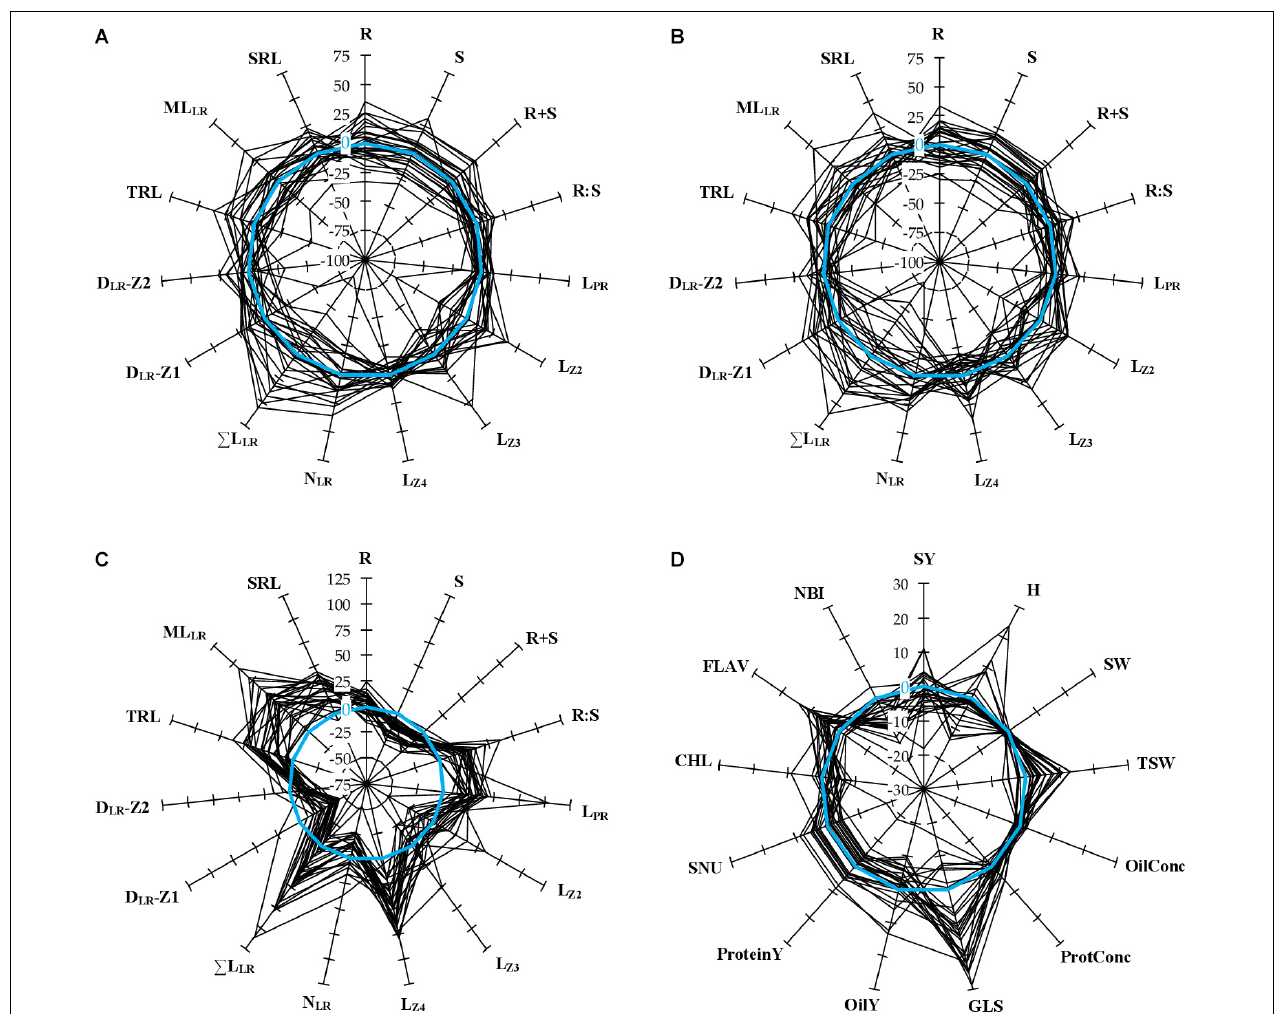
FIGURE 2 | Relative variation of phenotypic traits measured in 28 winter oilseed rape cultivars. (A,B) The spider plots show the percentage variation of biomass production and root morphological traits for every cultivar, normalized by the mean value of the panel, measured during N– (A) or N+ (B) conditions. Zero percent (blue circle) indicates no difference compared to the mean value of the panel in one condition. (C) The spider plot shows the percentage variation of biomass production and root morphological traits for every cultivar grown under N– conditions, normalized by the value observed under N+ conditions. This defines the responsiveness of one trait to N depletion. Zero percent indicates no difference compared to N+ conditions. (D) The spider plot shows the percentage variation of field traits for every cultivar, normalized to the mean value of three reference cultivars (DK Exception, DK Expansion, and DK Exstorm) over four growing seasons. Zero percent indicates no difference compared to the reference